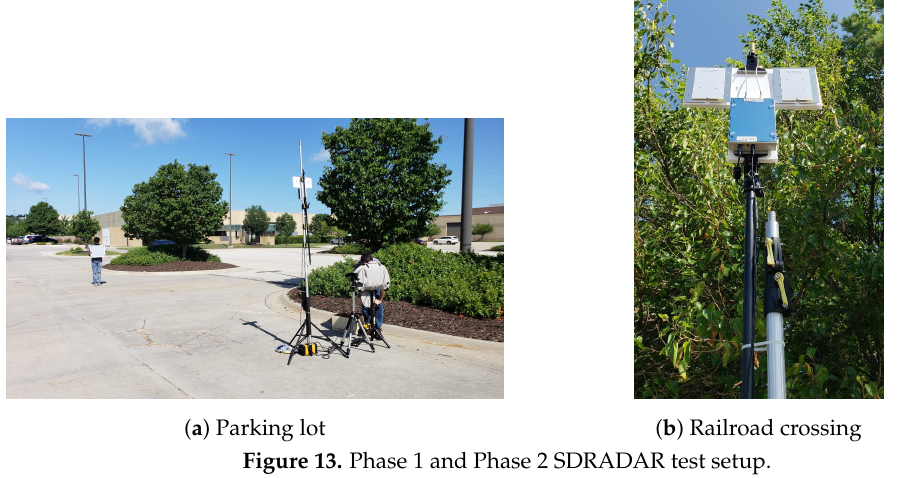
Figure 13. Phase 1 and Phase 2 SDRADAR test